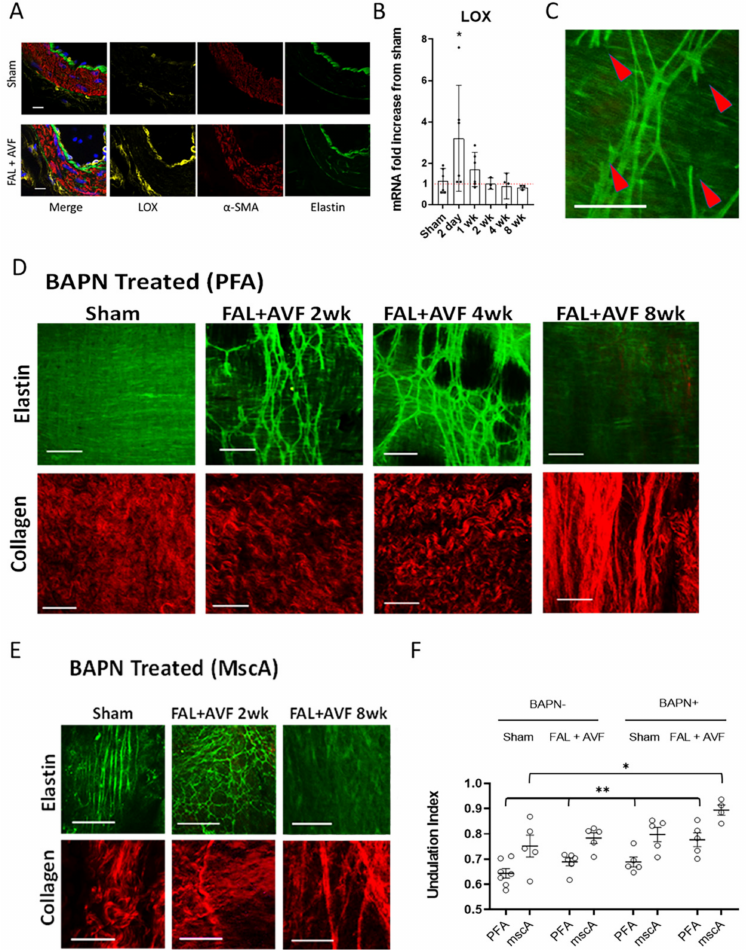
Figure 5. Elastic tissue fragmentation with inhibition of lysyl oxidase. ( A ) Representative cross sections of the PFA at 48 h stained for LOX and imaged with confocal microscopy (bar = 10 µ m; n = 4). ( B ) LOX mRNA expression is significantly increased in arteries subjected to FAL + AVF relative to sham arteries. ( n = 3–6, p < 0.05) ( C ) Enlarged image of PFA shows stubs of broken elastic fibers appearing in animals treated with BAPN (arrows). PFAs ( D ) and MscAs ( E ) were isolated from animals treated with BAPN after FAL + AVF after various time points, with images showing progressive loss of elastic tissue. ( F ) Comparison of undulation index among collagen fibers of the adventitia at 8 weeks ( n = 4–7 vessels analyzed per condition). Comparisons by two-way ANOVA, Tukey’s multiple comparison test. * p < 0.03, ** p < 0.05. Bar = 50 µ m. Images acquired with Olympus FV1000MPE utilizing 830 nm